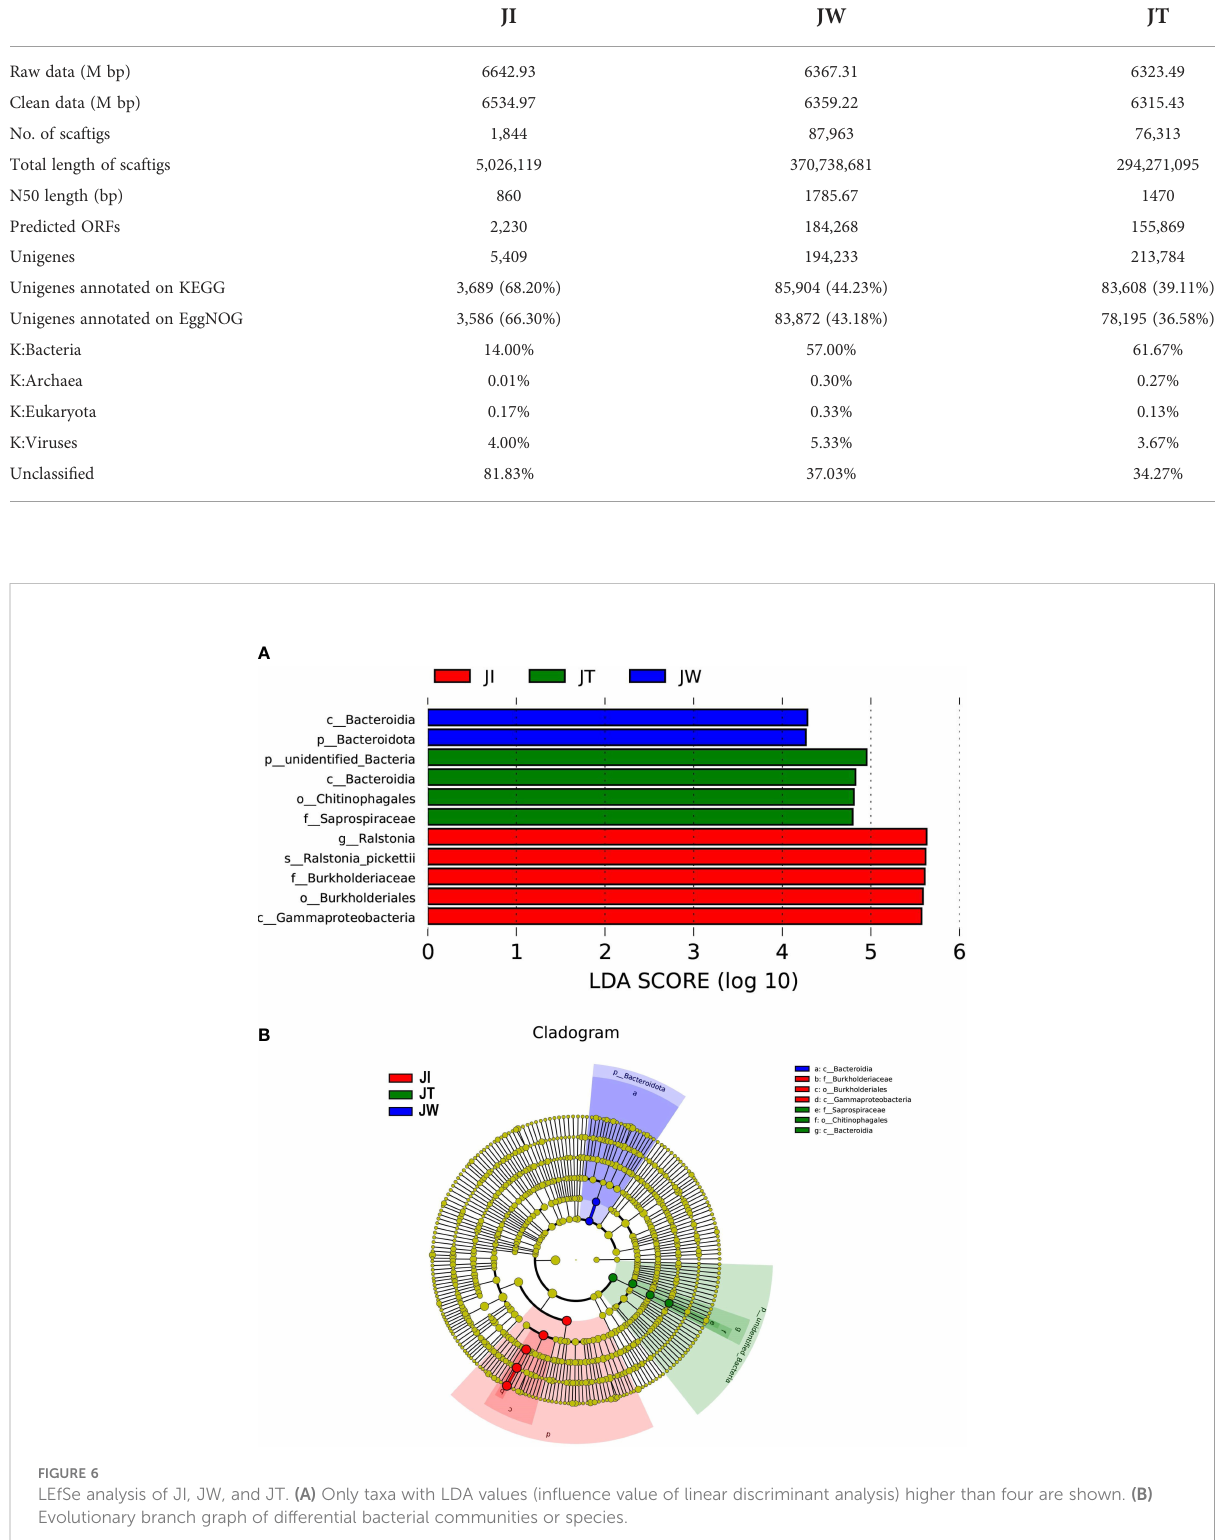
TABLE 4 Statistics of metagenome sequencing data from JI, JW, and JT in “ Fishery-PV Integration ” ponds.